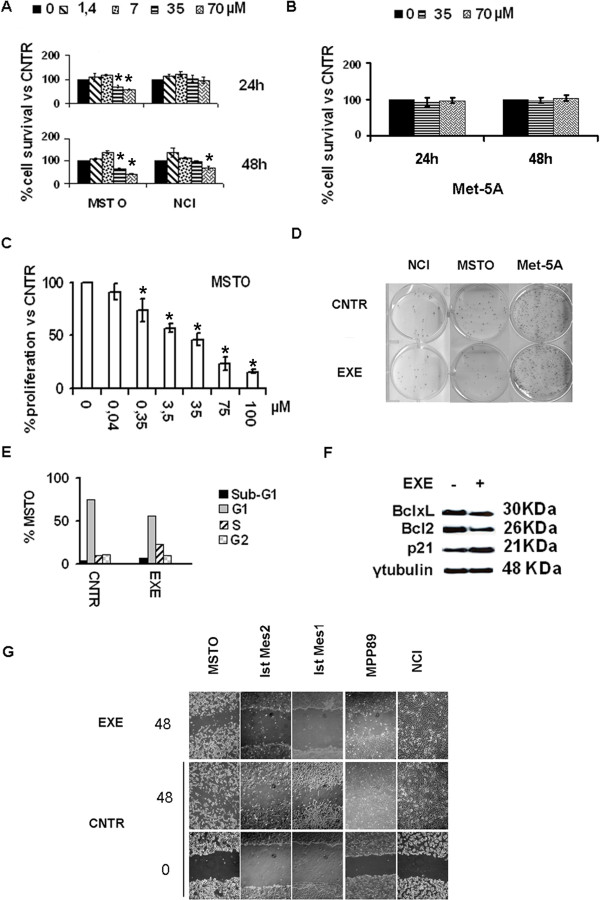
Exemestane acts on MPM cell growth, cell-cycle progression and migration. A, NCI was not very sensitive to exemestane (EXE), only 70 μM of drug for 48 h had a significant response versus untreated (CNTR) cells; B, exemestane was not effective in Met-5A. Significant decrease in MSTO cell growth was observed upon different exemestane dosage treatment as per XTT (A), manual cell counting (C) and clonogenicity assays (35 μM exemestane) (D). E, exemestane (35 μM) induced cell cycle arrest in S-phase; F, Western blotting showed increase in p21 and decrease in Bcl-2 and Bcl-xL expression. G, reduced MPM cell lines sensitive migration in response to 35 μM exemestane treatment was identified by wound healing assay. Cell migration was not inhibited in NCI. Graphs represent the average of at least 3 repeated experiments; *, statistically significant effects (P < 0.05).